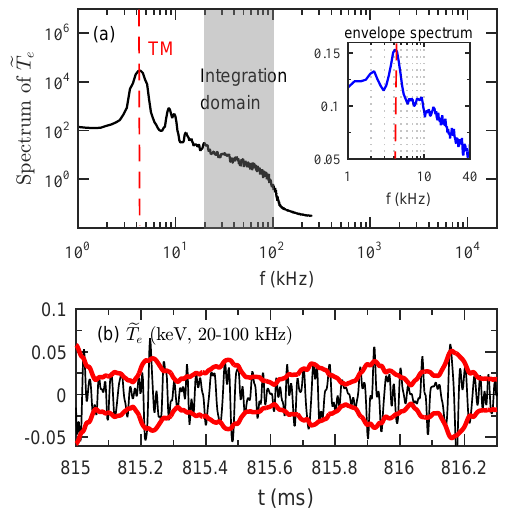
Figure 8. (a) Power spectrum of ˜ T e measured at R = 182.14 cm and Z = 3.46 cm. The inset in (a) shows the amplitude spectrum of the corresponding envelope signal, ξ ˜ ( t ) in the frequency range T e ∆ f = 20-100 kHz (shaded in (a)). (b) Time histories of ˜ T e (inte- grated from 20 − 100 kHz)and the envelopes of ˜ T e depicted by the black and red curves,